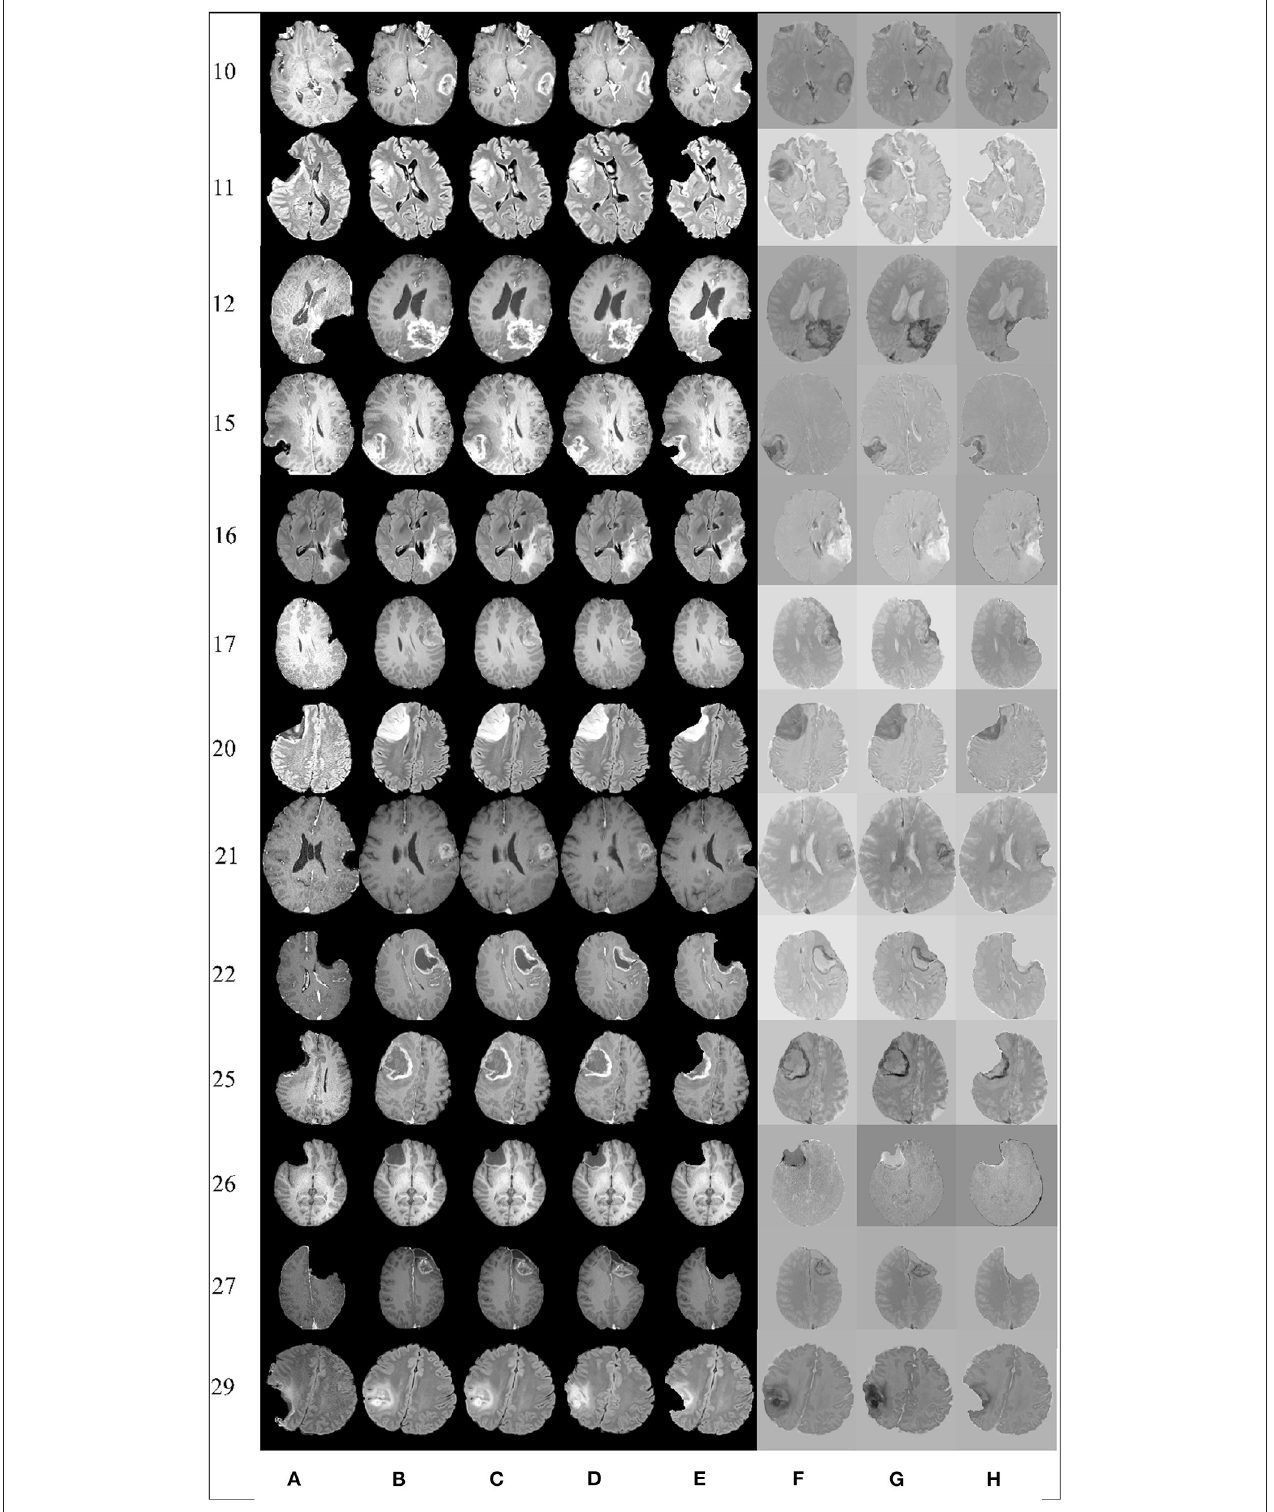
FIGURE 6 | Qualitative results. Each row represents the same slice of a 3D volume for the case numbered on the left. From left to right: intraoperative MRI (A) ; deformed preop MRI after (B) rigid registration, (C) B-Spline, (D) PBNRR, and (E) A-PBNRR; difference between intraoperative MRI and (F) B-Spline, (G) PBNRR, and (H) :